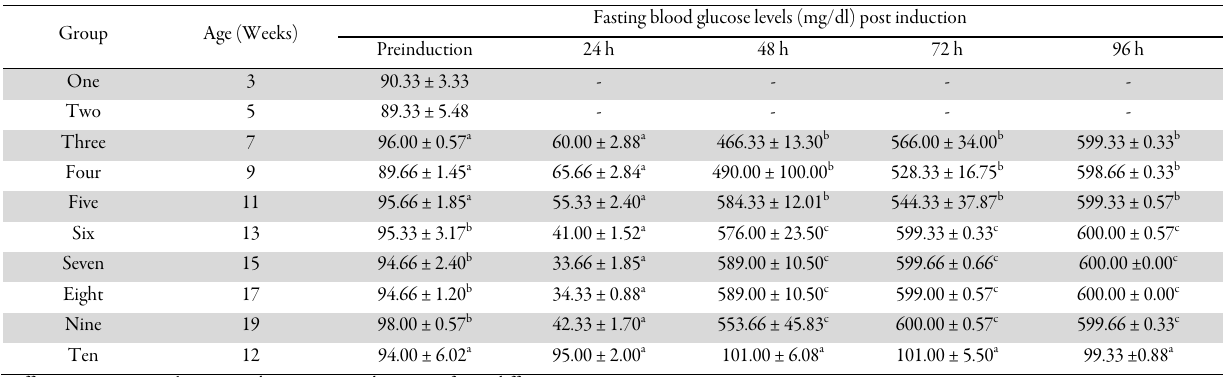
Different superscripts a,b,c across the same row indicate significant difference at p<0.05 Table 2. Percentage changes in FBG levels of alloxan-induced diabetic rats of varying ages monitored for 96 h Group Age (Weeks)